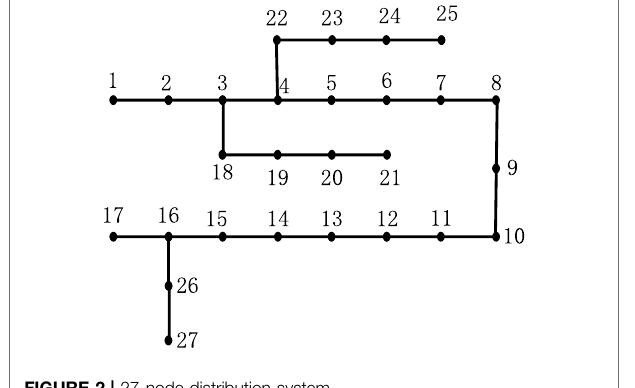
FIGURE 2 | 27-node distribution system.